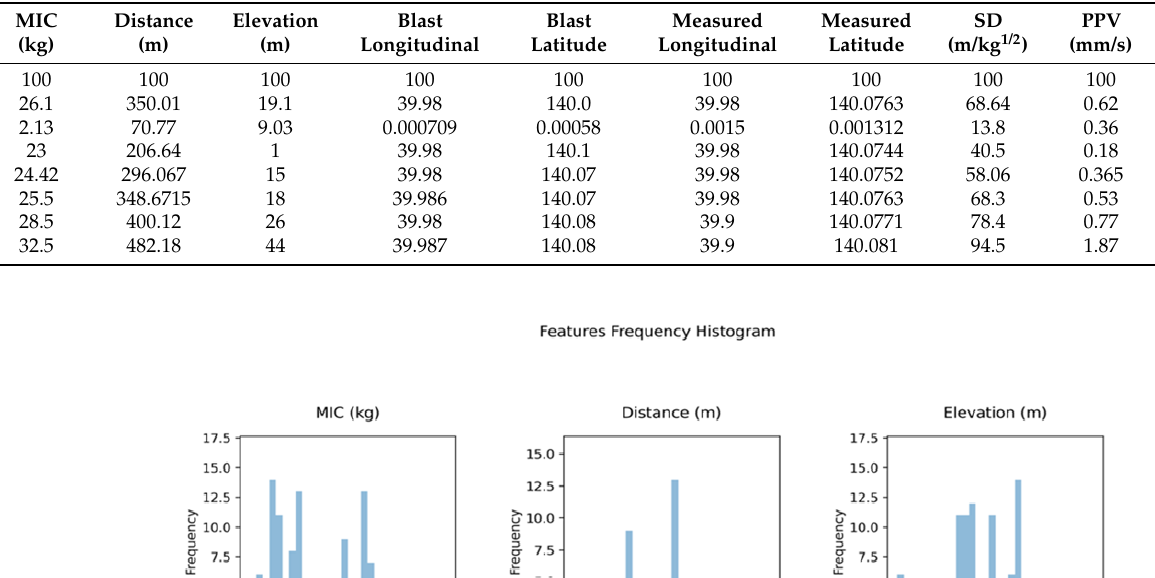
Table 2. Descriptive statistics of the input and output variables.